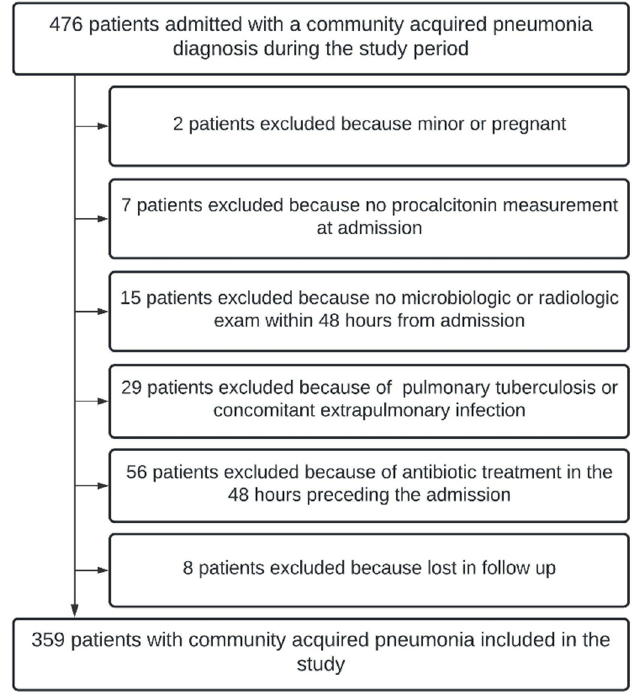
Figure 1. Study-inclusion